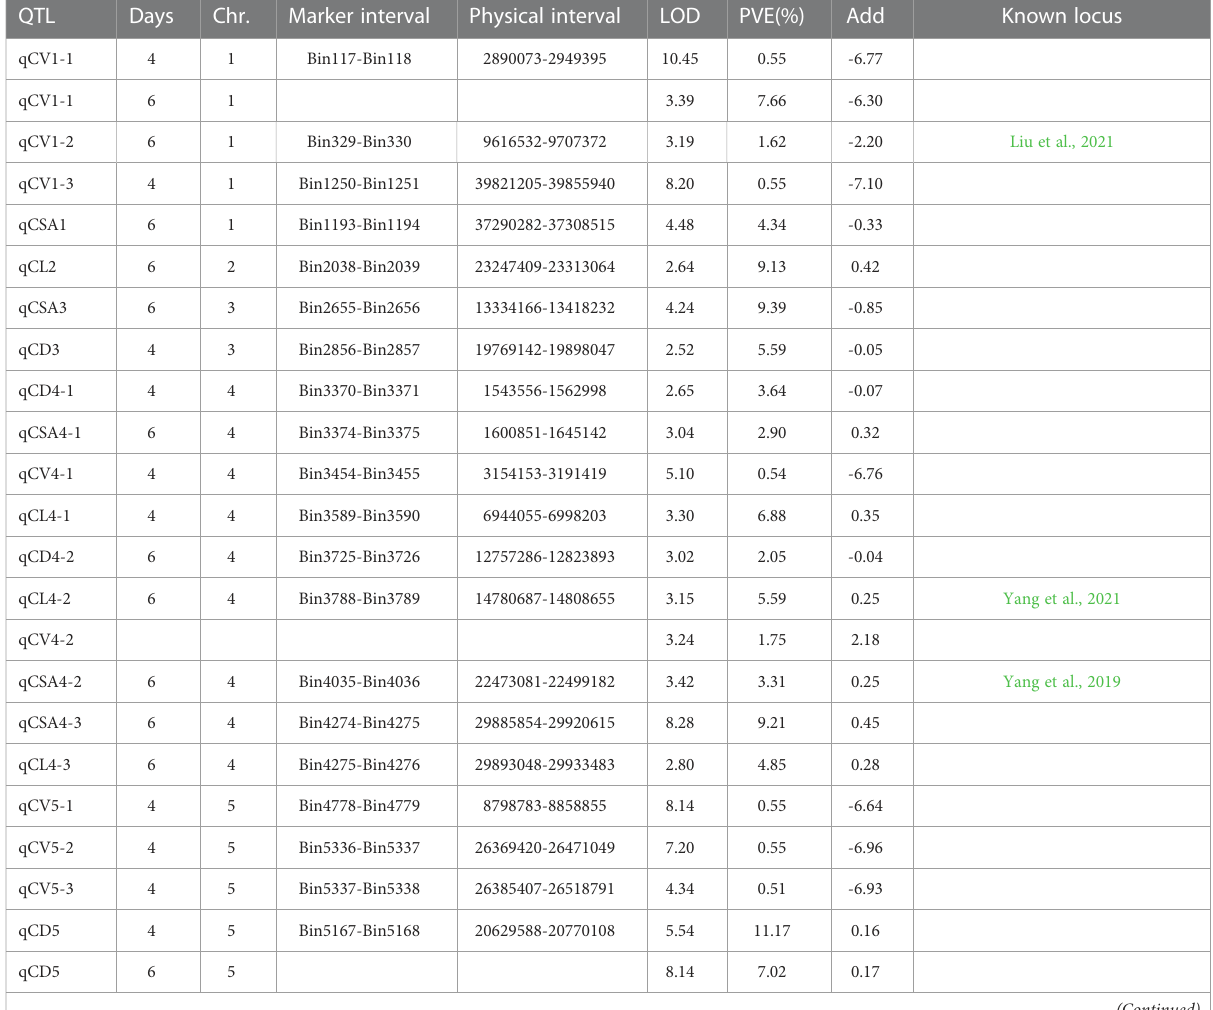
TABLE 2 QTLs associated with coleoptile traits during two periods of hypoxic germination. QTL Days Chr. Marker interval Physical interval Known